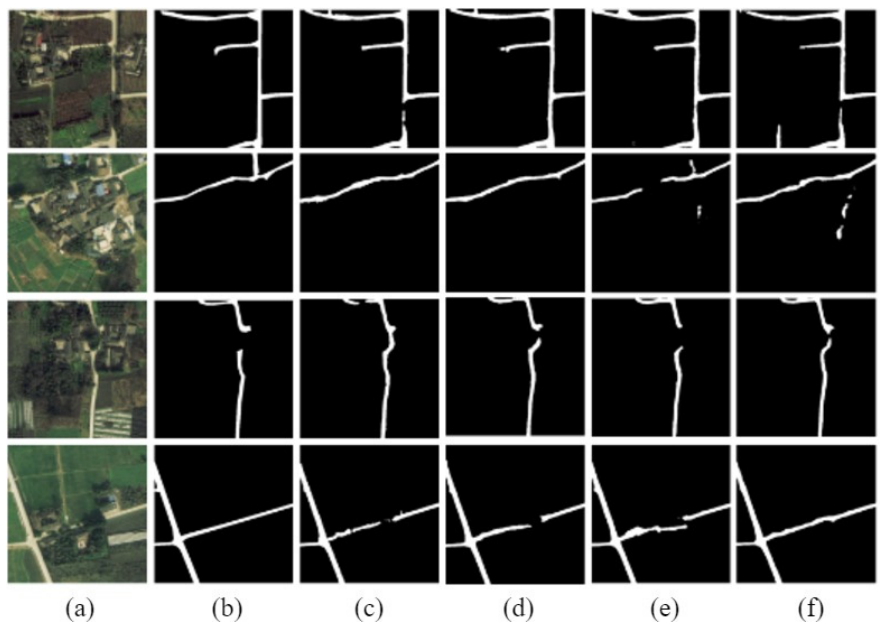
Figure 13. Comparison results of complex scene experiment. ( a ) Original image; ( b ) label image; ( c ) D-LinkNet_50; ( d ) D-LinkNet_101; ( e ) D-LinkNetPlus_50; and ( f ) D-LinkNetPlus_101.